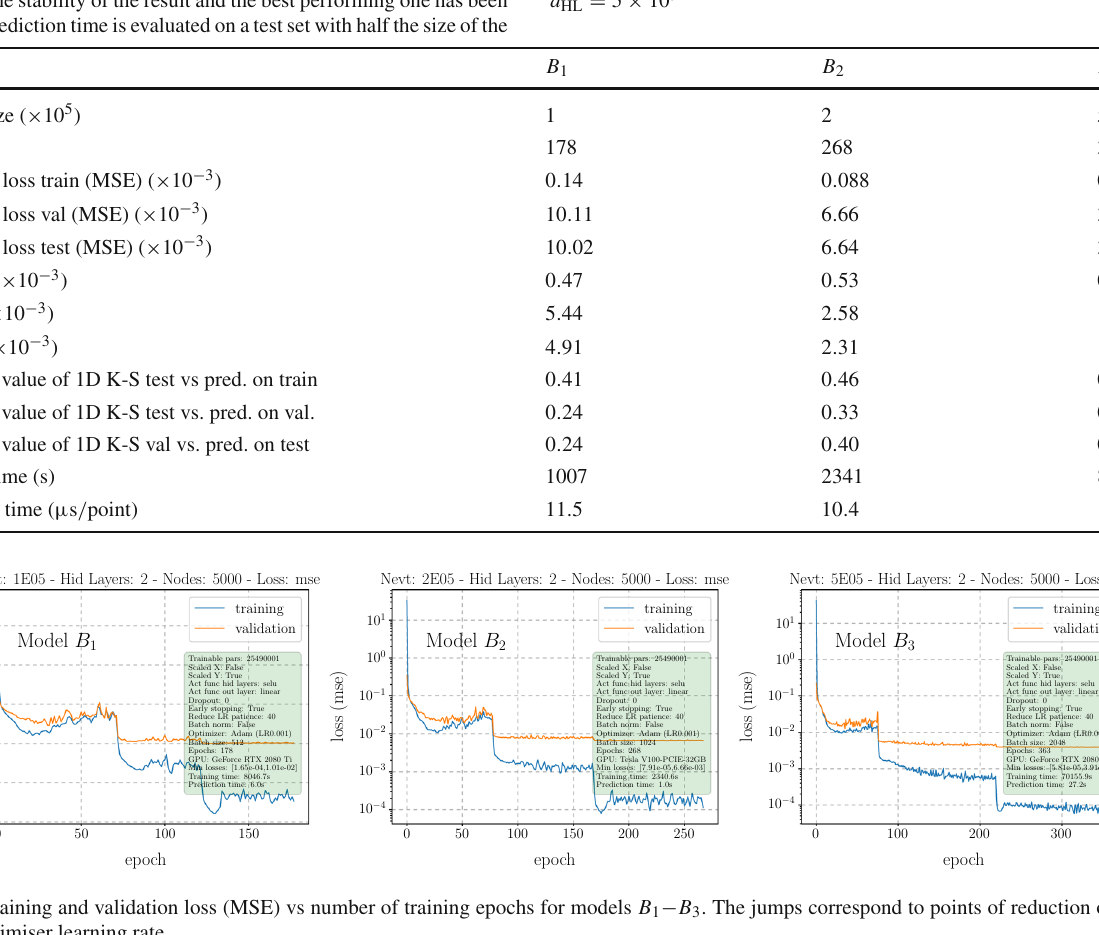
the choice of hyperparameters. Once the best model has been chosen,theresultofreweightinghasbeencheckedbydirectly sampling the DNNLikelihoods with emcee3 . 14 We present results obtained by sampling the DNNLikelihoods in the form of 1D and 2D marginal posterior density plots on a chosen set of parameters (μ, δ 50 , δ 91 , δ 92 , δ 93 , δ 94 ) . We have sampled the LF using the